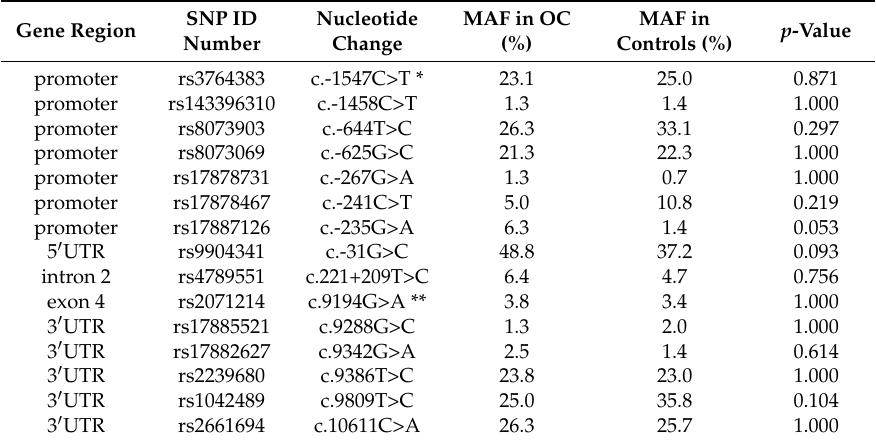
Table 2. BIRC5 polymorphisms in OC samples and healthy controls. MAF, minor allele frequency; OC, ovarian